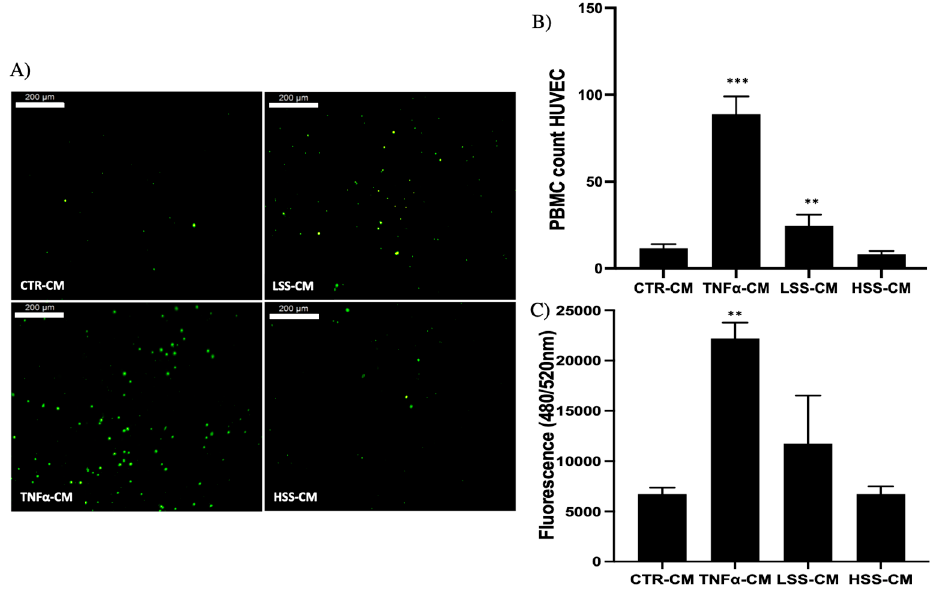
Figure 9. PBMC adhesion assay on HUVEC monolayer cultured for 24 h with TNF α -, LSS- and HSS-conditioned media (- CMs). ( A ) Immunofluorescence imaging of representative fields of the different conditions. ( B ) Adherent PBMC absolute HSS-conditioned media (-CMs). ( A ) Immunofluorescence imaging of representative fields of the count on HUVEC monolayers. ( C ) Fluorescence quantification of the adherent PBMCs (** p < 0.01 and *** p < 0.005). Scale- different conditions. ( B ) Adherent PBMC absolute count on HUVEC monolayers. ( C ) Fluorescence bar: 200 μ m. quantification of the adherent PBMCs (** p < 0.01 and *** p < 0.005). Scalebar: 200 µ